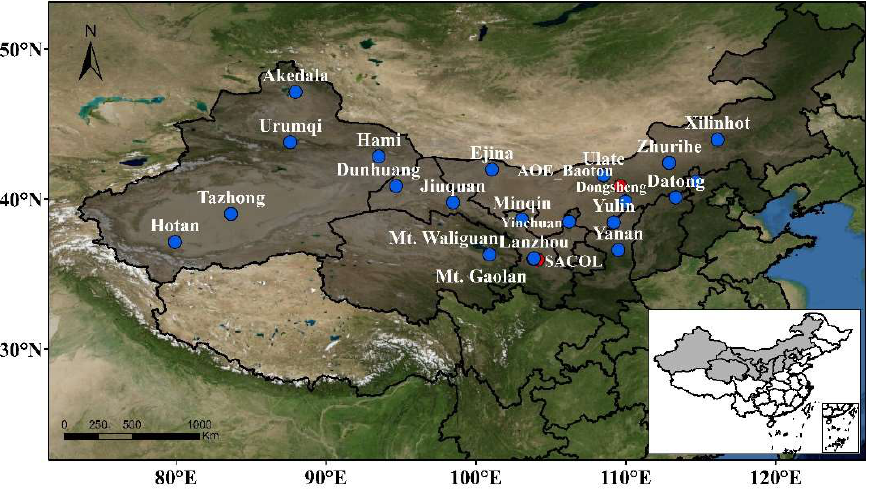
Figure 1. True color image of Northwestern China and the geolocation of CARSNET and AERONET sites. The blue and red dots denote CARSNET and AERONET sites respectively. Table 1. Detailed information for CARSNET and AERONET in Northwestern China (Two sites marked with * are AERONET sites, and the remaining 21 are CARSNET sites).